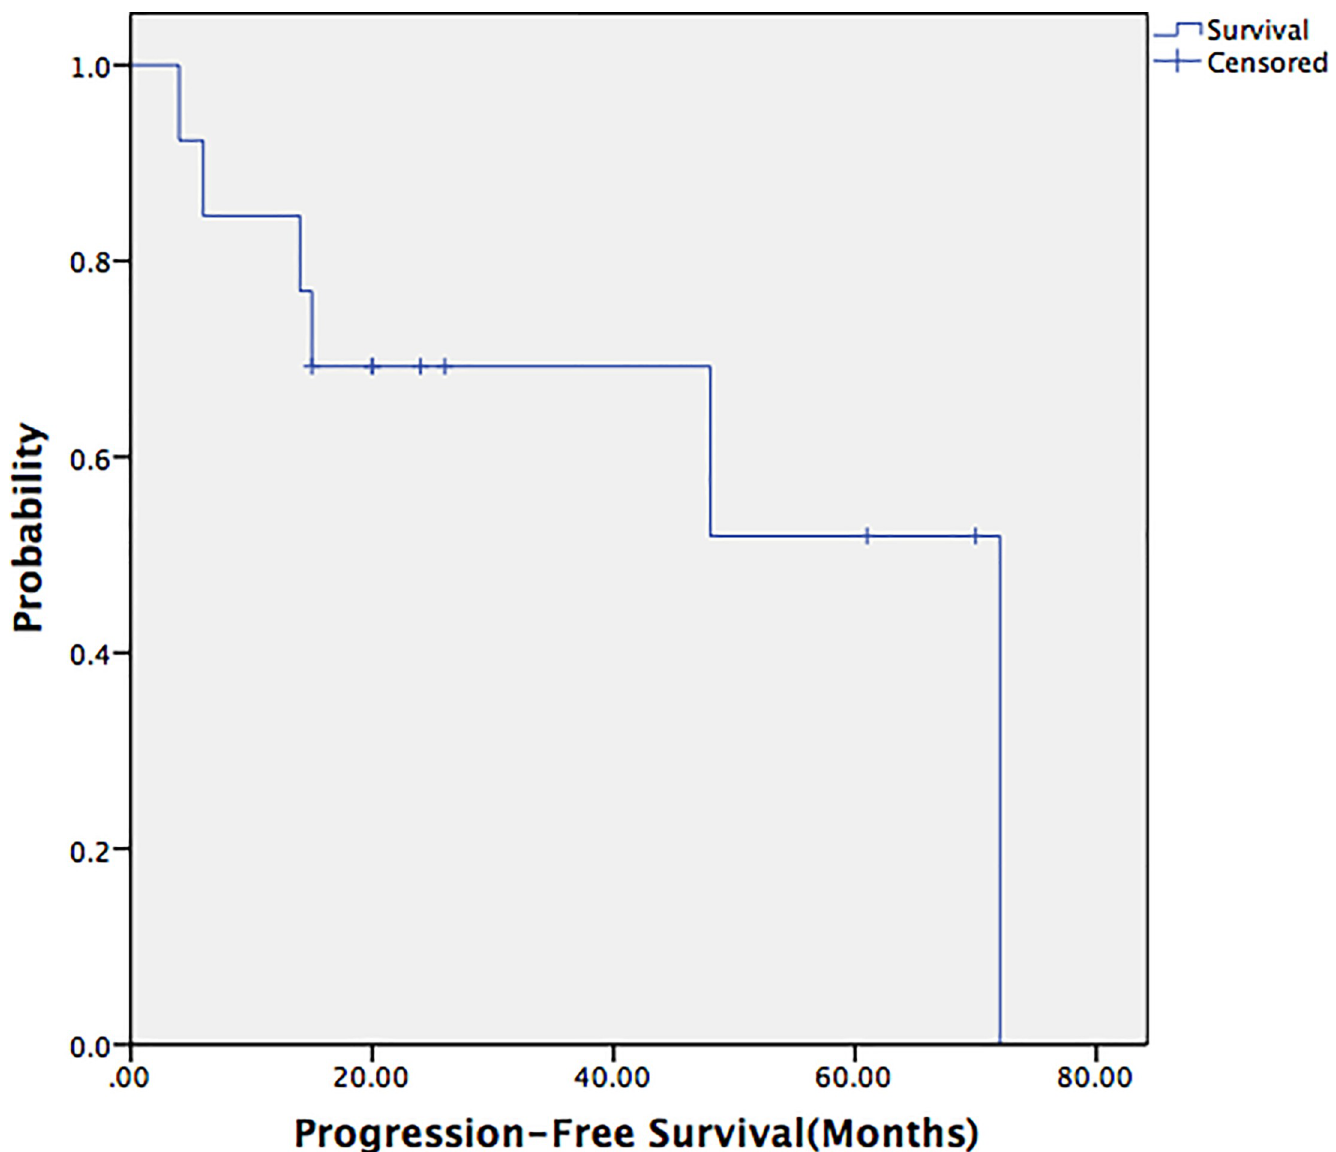
Fig 2. Progression-free survival curve of the 13 patients. The 5-year progression-free survival rate was 63.5%.